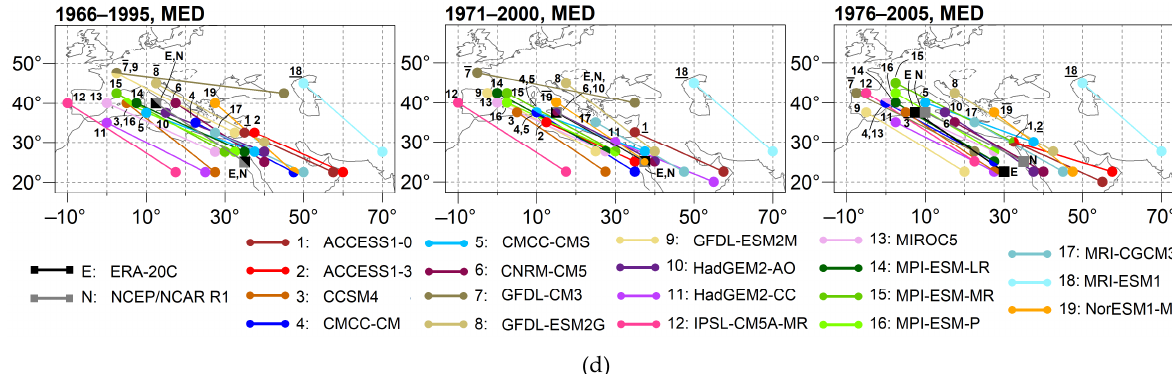
Figure 6. The ACs obtained from the reference clusters of the ERA ‐ 20C and the closest ACs obtained from the NCEP/NCAR R1 and the GCMs in cases of the clusters ( a ) PAC, ( b ) ASIA, ( c ) ATL, and ( d ) MED. The letters E and N stand for the reanalyses ERA ‐ 20C and NCEP/NCAR R1, respectively, while the numbers near the northerly ACs denote the GCMs. If the coordinates of two or more reanalyses/GCMs are the same, then their symbol is divided and filled with two or more colors. The clusters that belong to types 2 and 3 according to Section 3.3.1 are denoted with underscored and overscored numbers, respectively.